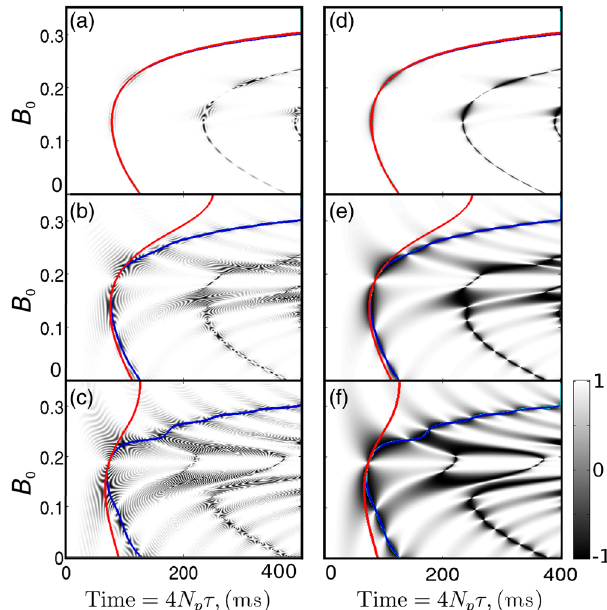
FIG. 4. Comparisons between the dip positions obtained with Eq. (4) (blue line) and average Hamiltonian theory Eq. (7) (red line) for the full coherence function (left) as well as its envelope (right). Within the field sweep there are global weak-coupling points (e.g., B 0 ≈ 0 . 19 T) where there is weak coupling regard- less of the cluster properties and where the decoherence envelope collapses into a single sharp dip, a useful feature if high resolution is required: here, there is always good agreement with average Hamiltonian theory. These points correspond to so-called optimal working points [31,32] of silicon donors. Hence, the advantage of such systems as future spin sensors, in addition to their very long ∼ 1 s coherence times, is that a magnetic field sweep could tune the dynamics from the weak- to strong-coupling